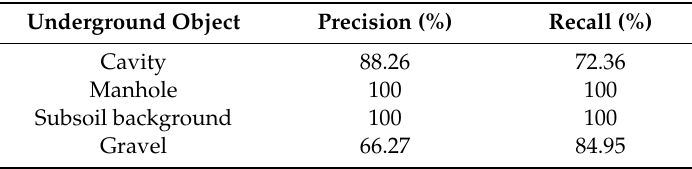
Table 1. Statistical results obtained from conventional